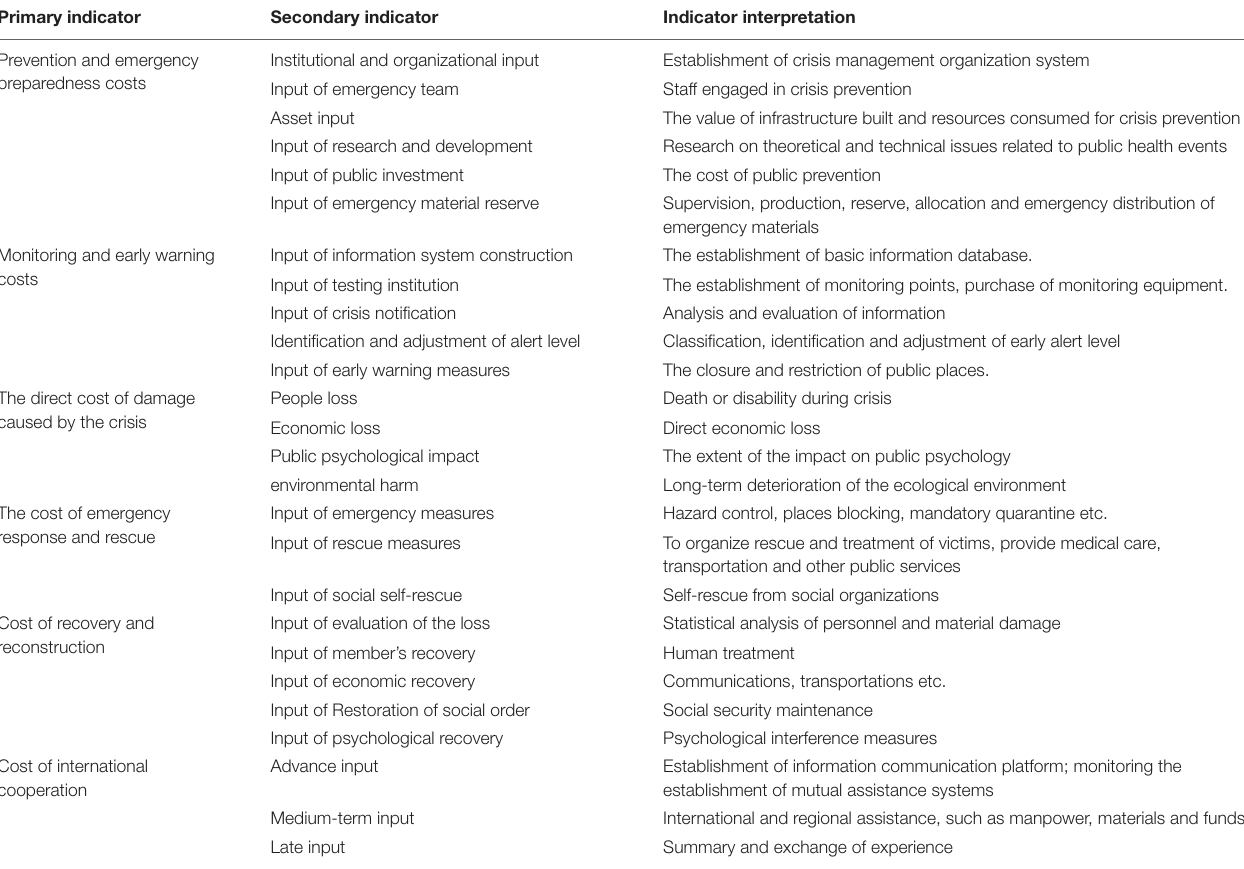
TABLE 4 | Cost analysis of emergency public security